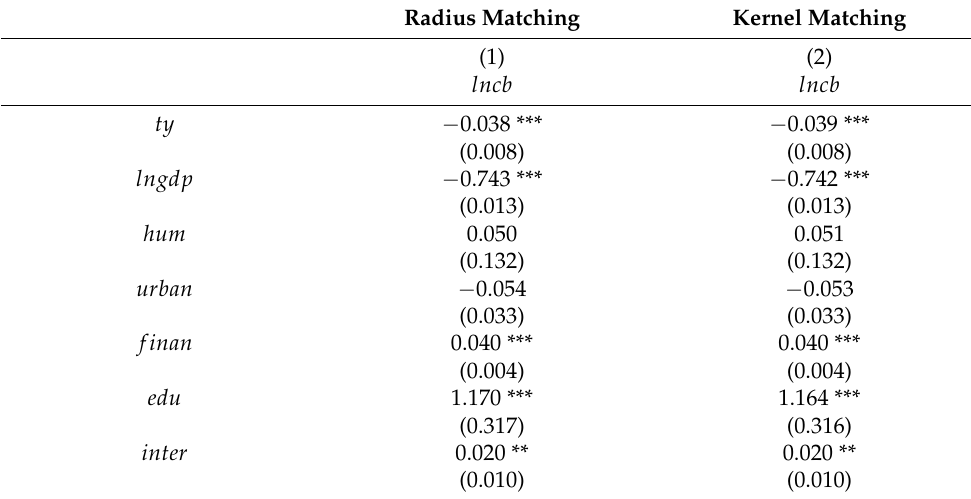
Table 5. PSM-DID